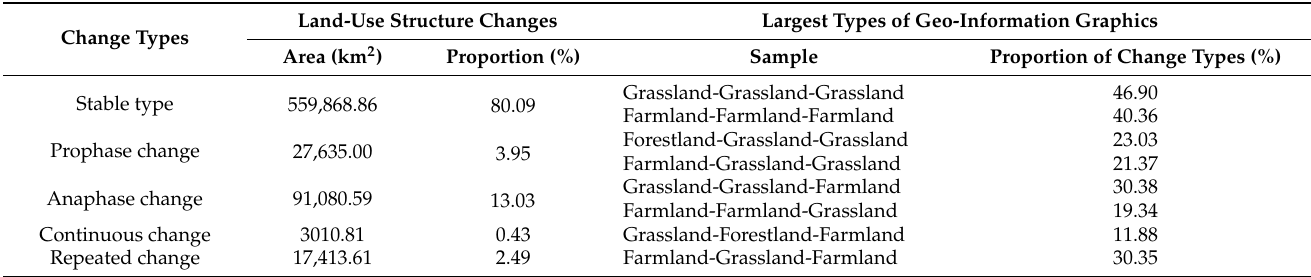
Table 7. Geo-information graphic type of land-use structure change in the AENC during 2000–2020.